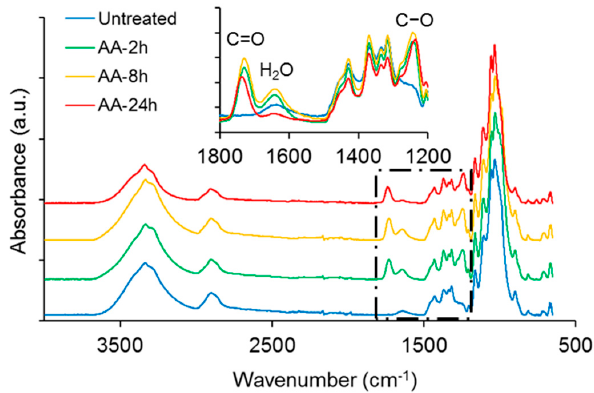
Figure 1. Attenuated Total Reflectance-Fourier Transform Infrared (ATR-FTIR) spectra of nanofibrillated cellulose (NFC) modified with (2-dodecen-1-yl)succinic anhydride (DDSA) and acetic anhydride (AA), respectively, compared to unmodified NFC. Table 1. Peak height ratio ( I 1730 / I 1055 ) of DDSA- and AA-modified NFC samples as derived from ATR-FTIR measurements as a function of reaction time.